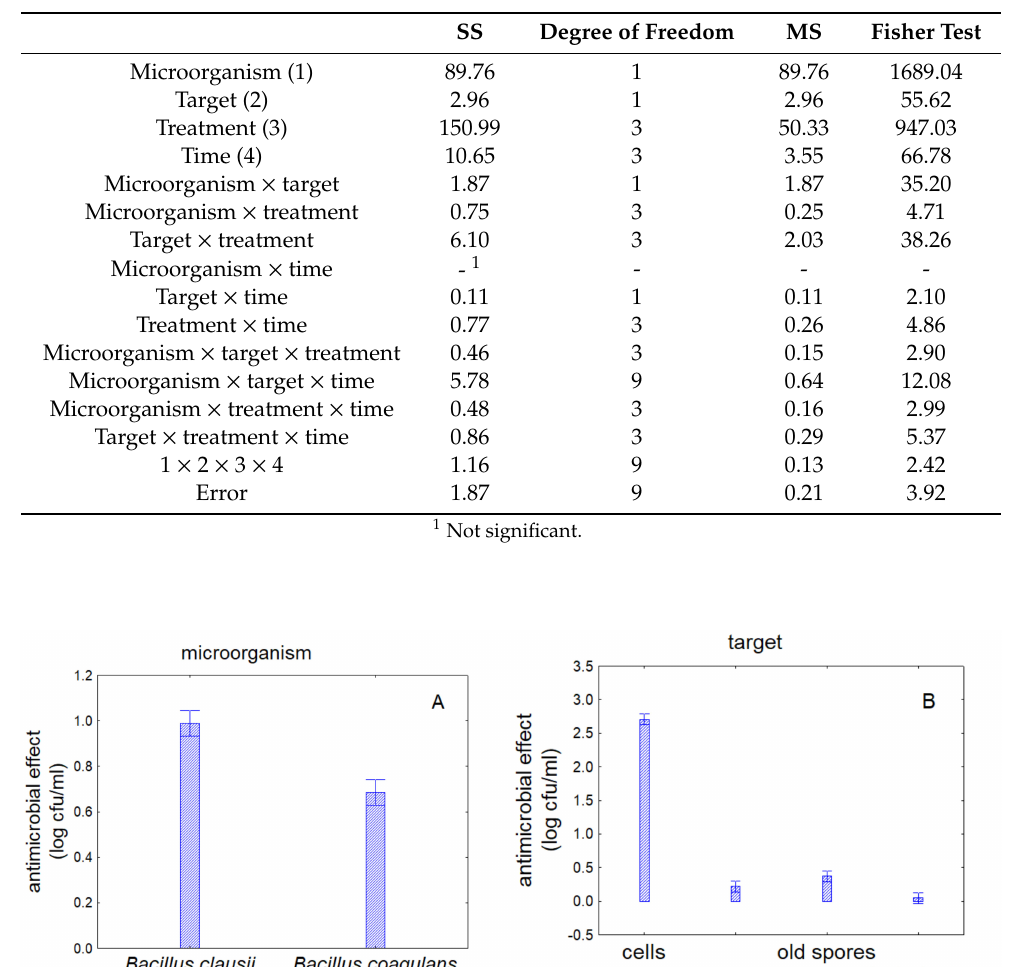
Table 2. Standardized e ff ect of microorganism ( Bacillus clausii or B. coagulans ), treatment (citrus or lemon extract, US or thermal treatment), time (immediately after the treatment and after 2 days) and target (cells, spores, old spores, and activated spores) on the antimicrobial e ff ect (decrease of viable count, log cfu / mL). SS, sum of square residual; MS, mean square residual.